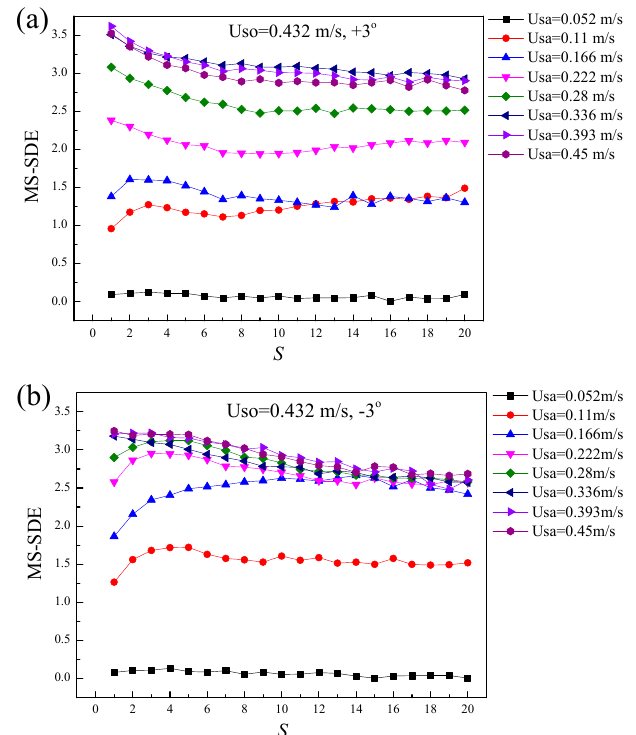
Figure 19. The multiscale short-term distribution entropy (MS-SDE) for the inclined liquid-liquid flows: ( a ) Uso = 0.432 m/s, +3°; ( b ) Uso = 0.432 m/s, − 3°.